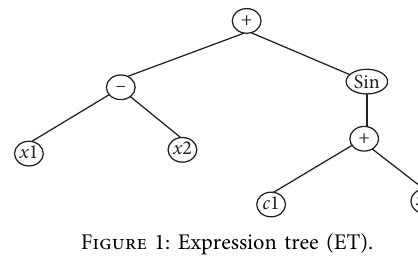
Figure 1: Expression tree (ET).